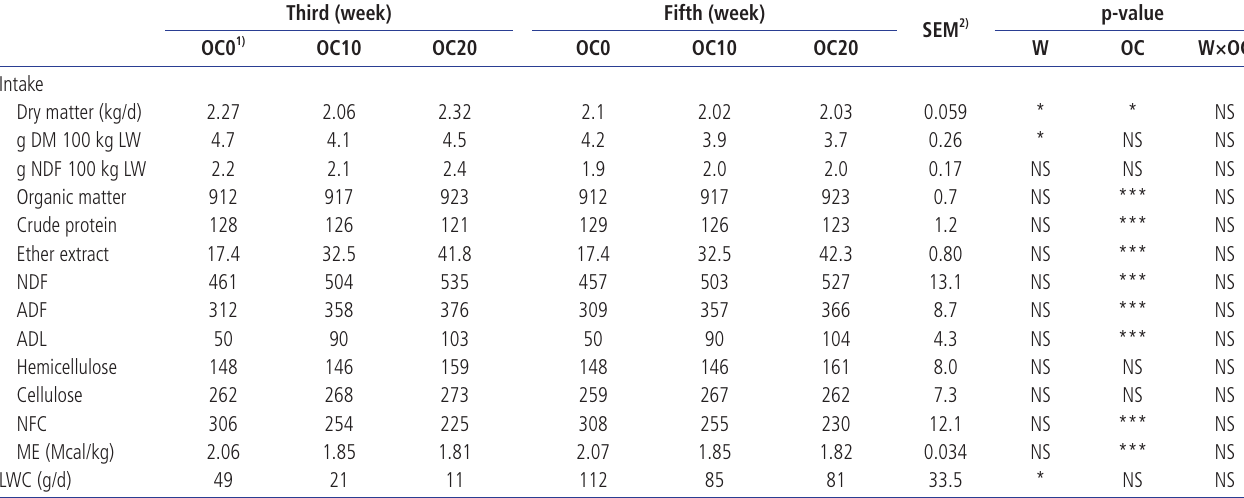
Table 3. Effect of dietary treatment and sampling time (third and fifth week of the experiment) on intake (g/kg DM, except DM) and live weight change (g/d) of dairy goats Third (week) Fifth (week)